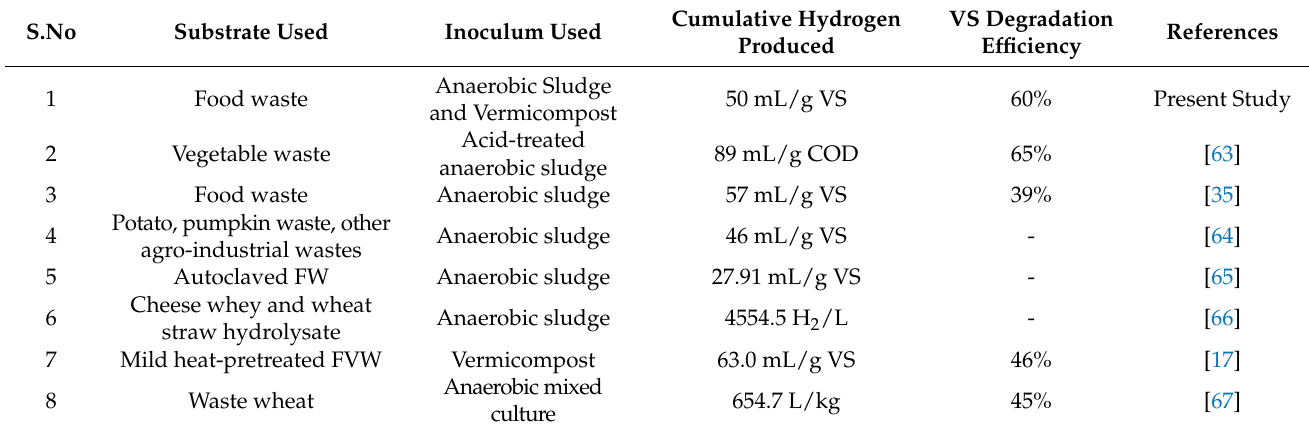
Table 1. Biohydrogen Production from various biodegradable